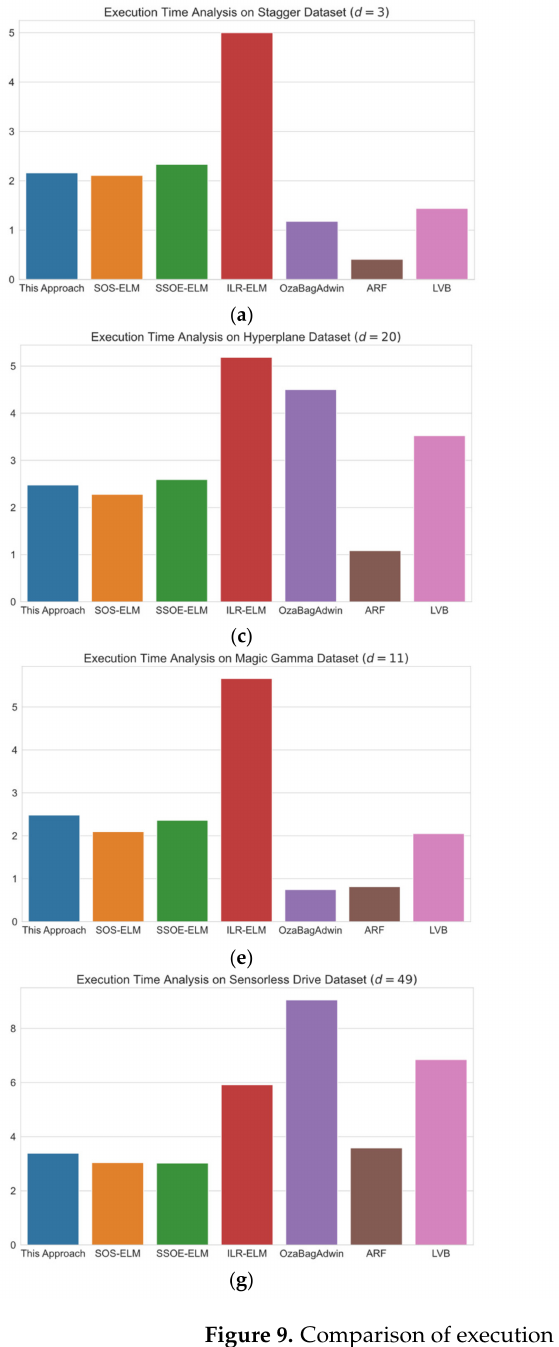
Figure 9. Comparison of execution time of this approach and different baselines. ( a – h ) The results of the execution time from the dataset listed in Tables 3 and 4, where d is the dimensionality of the